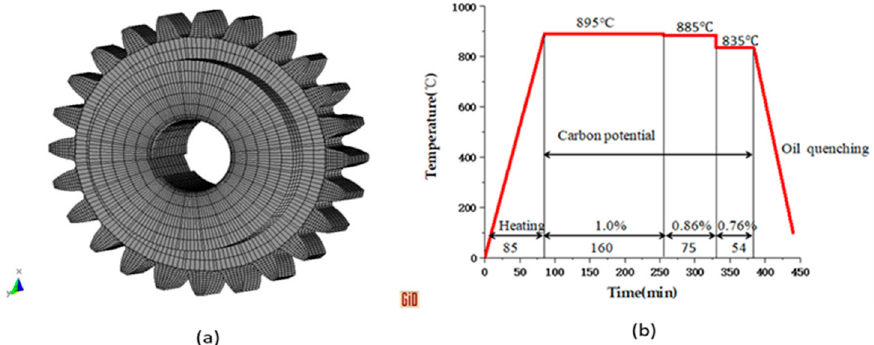
Figure 9. Geometric model and process conditions. ( a ) Finite element model; ( b ) carburizing and quenching process conditions.